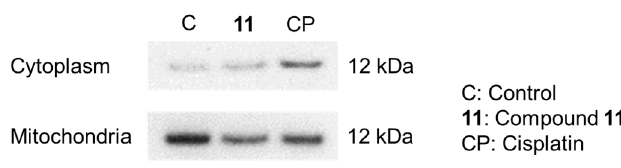
Figure 7. Effects of treatment with 10 µM of 11 or 33 µM of etoposide for 6 h on protein expression of cytochrome c in mitochondrial and cytosolic fractions of HL-60 cells.